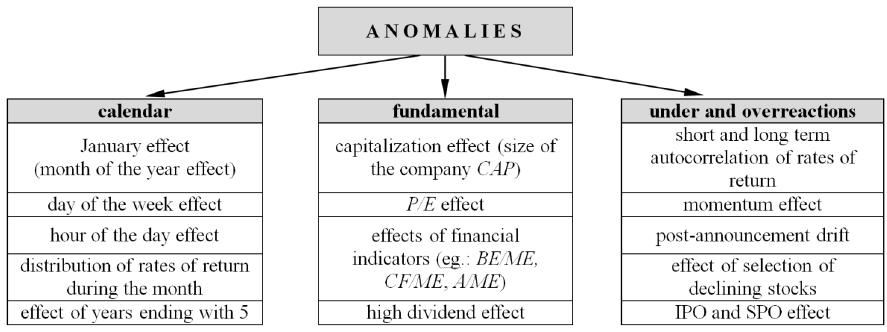
Figure 2. Most popular equity market anomalies Source: (Jamróz, 2011, p.